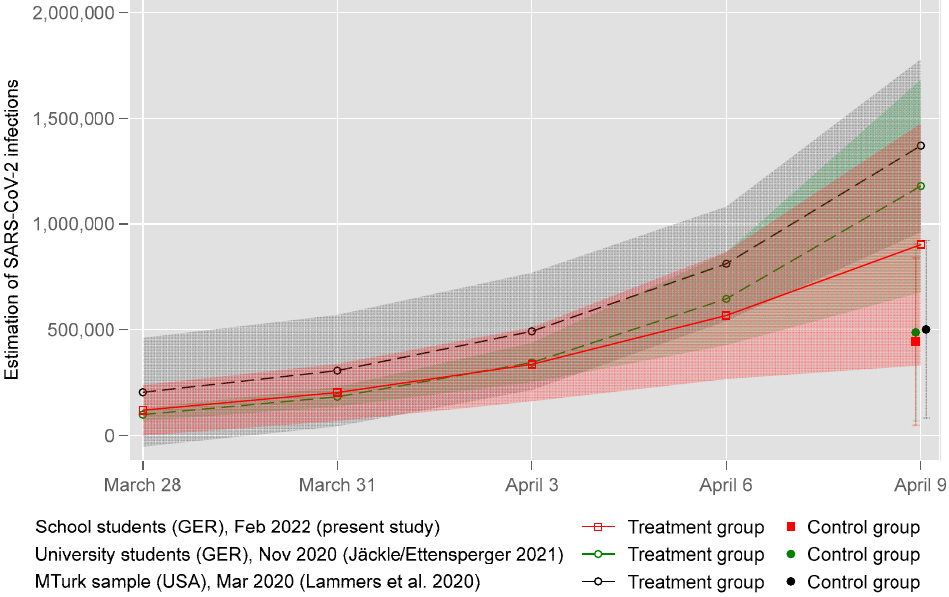
Figure 2. Estimated number of infections with SARS-CoV-2 made by the participants (Mean ± 1 SD).